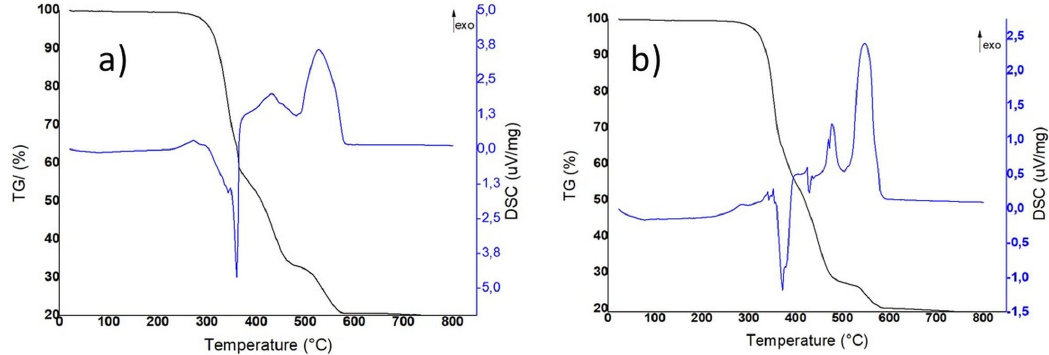
Figure 7. TG-DTA curve of the uncoated CVC ( a ) and coated CVC ( b ).